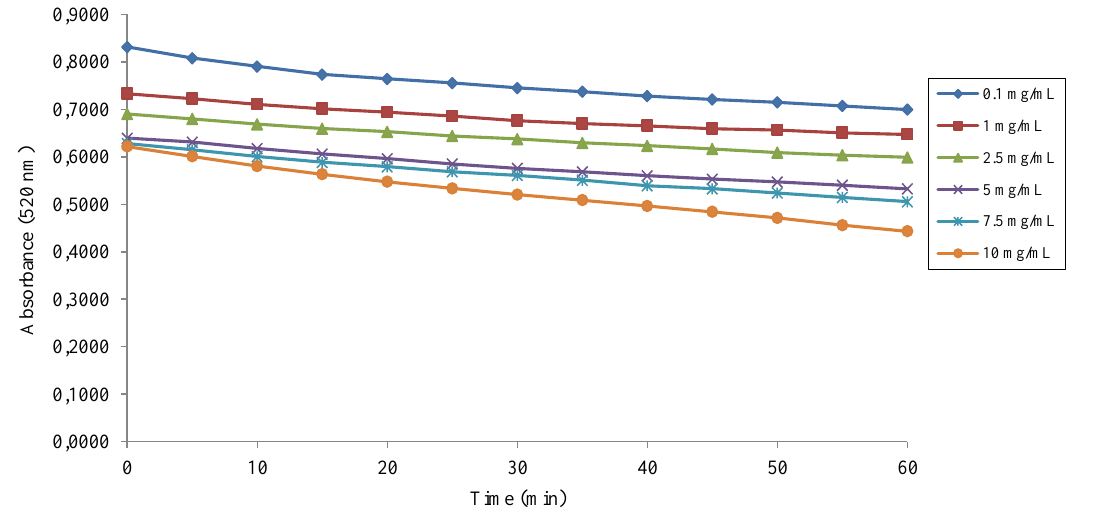
Figure 2. Kinetics of entrapment of DPPH• with respect to the concentration of the compound C1 .